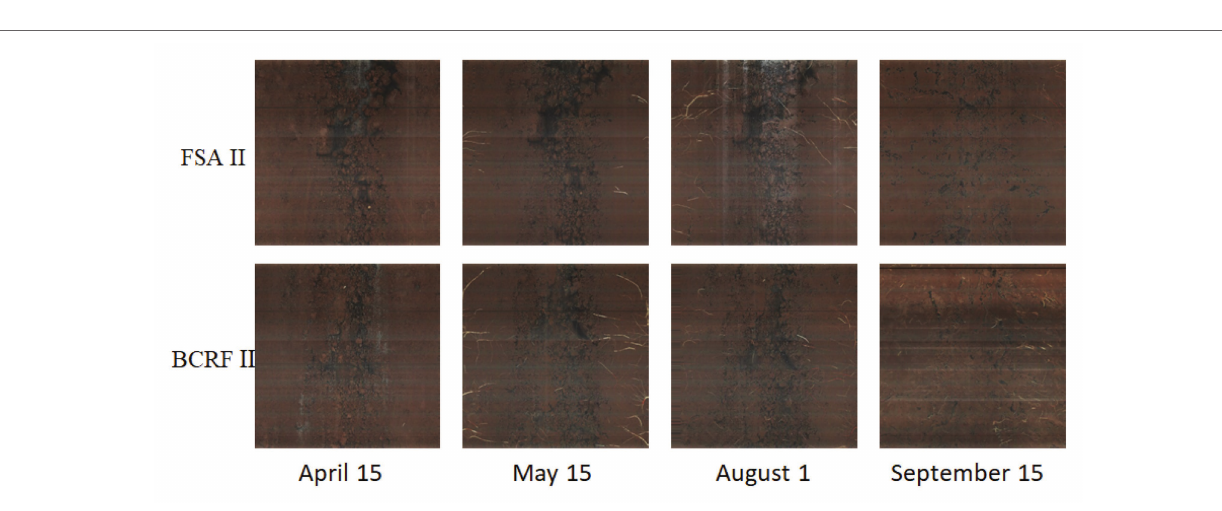
FIGURE 10 | Root scanning pictures of peach trees under different fertilization